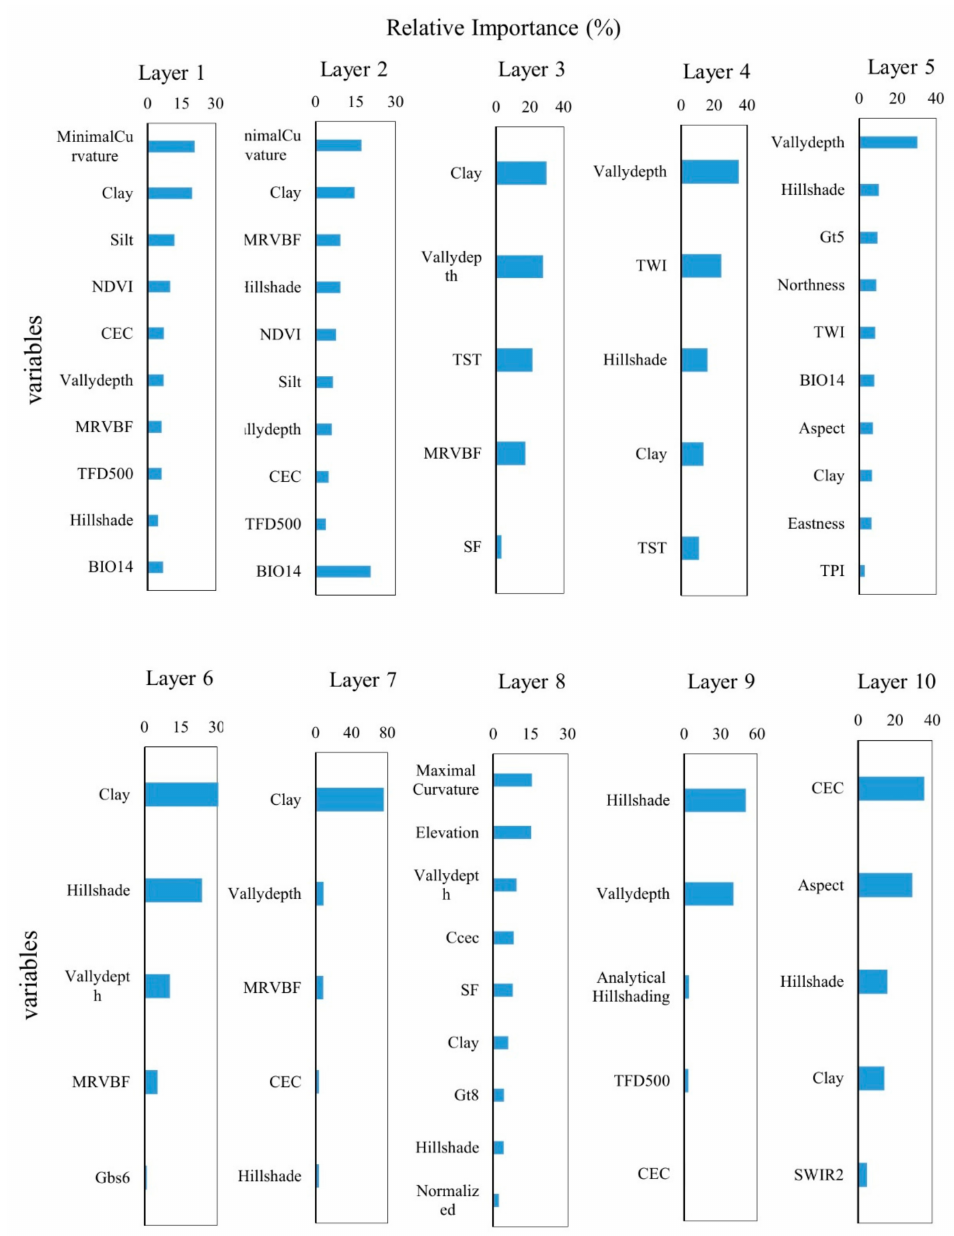
Figure 9. Variable importance for SOC stocks prediction in different depth at Ag > 50–Fo < 50 class by